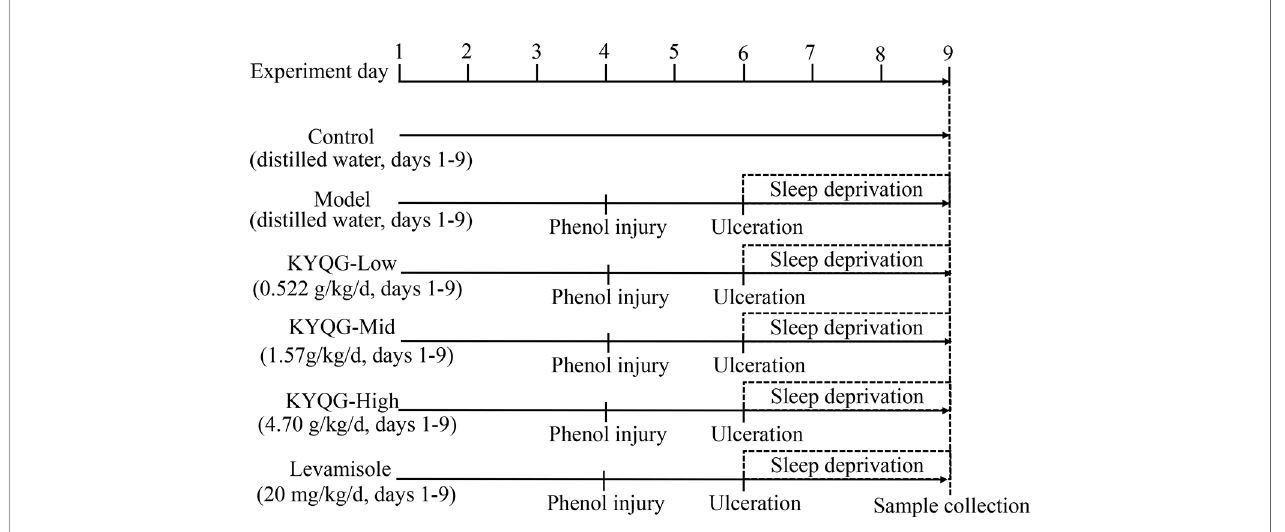
FIGURE 1 | Schematic representation of the experimental protocol showing the sequence of events throughout the